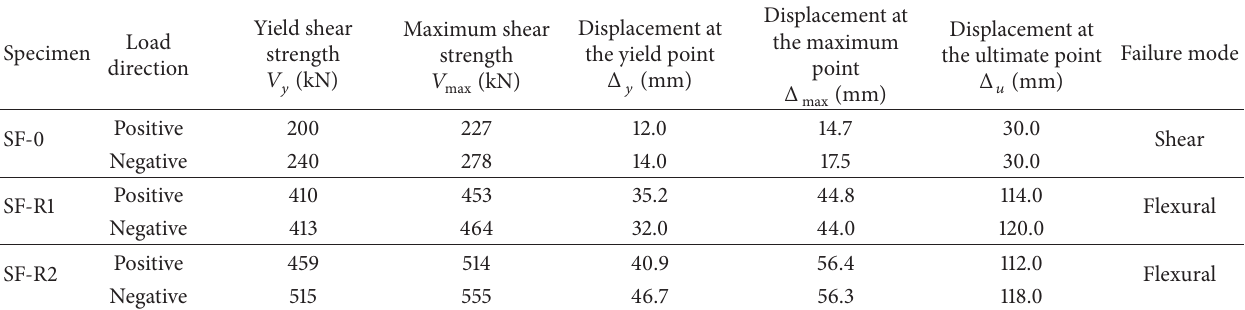
Figure 6: The experimental configuration used during the cyclic loading tests. Table 8: Results of mechanical characterizations of the test